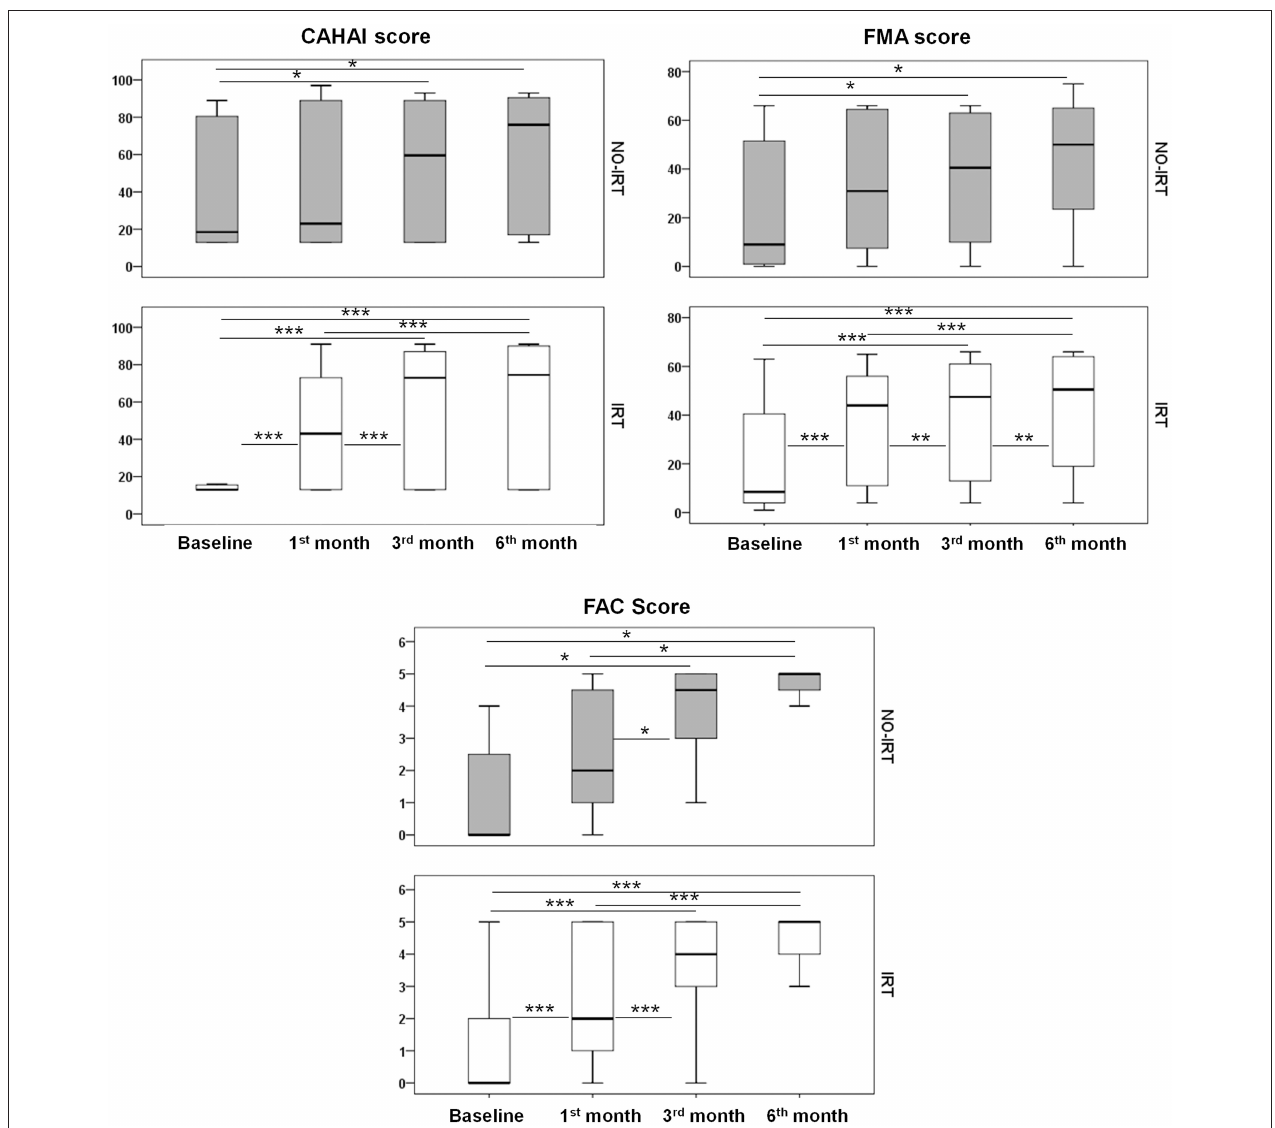
FIGURE 2 | Functional outcome. Temporal profile of the tested scales in IRT and NO-IRT cohorts. Note that in the 1st month significant improvements were only achieved in the IRT group. Differences were assessed with the Wilcoxon tests and the Man-Withney U for the transversal analysis. * p < 0.05; ** p < 0.01, and *** p < 0.001. Median and IQR are represented in box